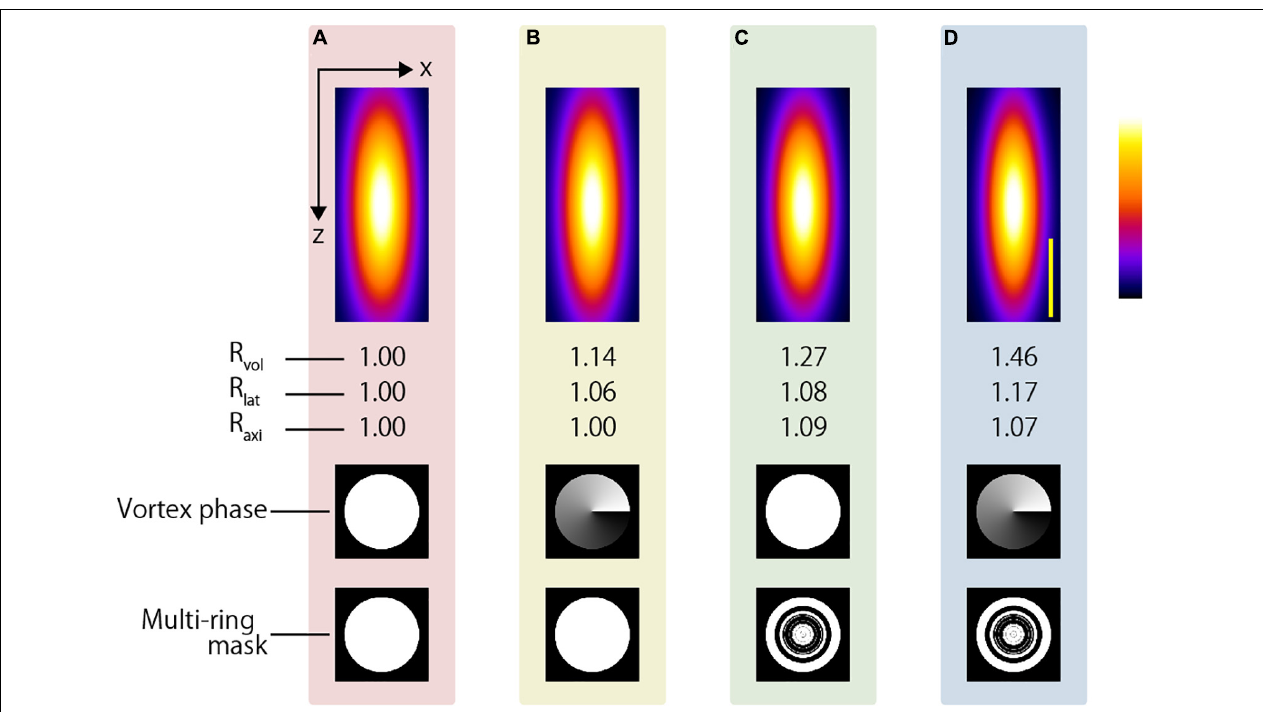
FIGURE 12 | Simulation results of two-photon PSFs when the water immersion objective lens with NA = 1.05 is used to focus using the (A) CP, (B) APV, (C) AMCP, and (D) AMAPV excitation beams. Top: the x-z projected images of the two-photon PSFs. Middle row: phase patterns for realizing the first resolution-enhancement method. Bottom: eight-ring mask pattern for realizing the second resolution-enhancement method. Scale bar: 500 nm.